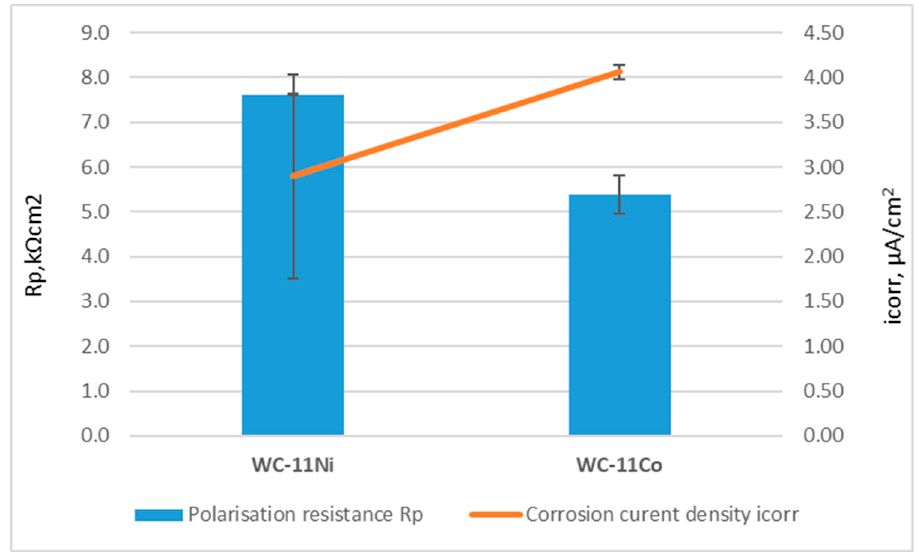
Figure 6. The dependence of R p and i corr in relation to binder composition.